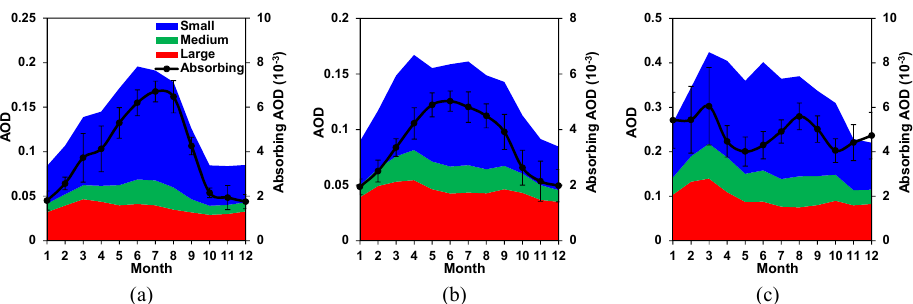
Figure 6. Monthly mean AOD of different aerosol types observed by MISR during 2007–2016 in (a) EUS, (b) WEU, and (c) ECC. The size-resolved AODs are depicted by the colored stacks (left Y axis); the integration of the three size ranges yields total column AOD, as represented by the upper edge of the blue color. The AOD of absorbing aerosols is shown as solid lines (right Y axis), for which the error bars are defined in the same way as in Fig. 2. Note the different scales on the y axes of the